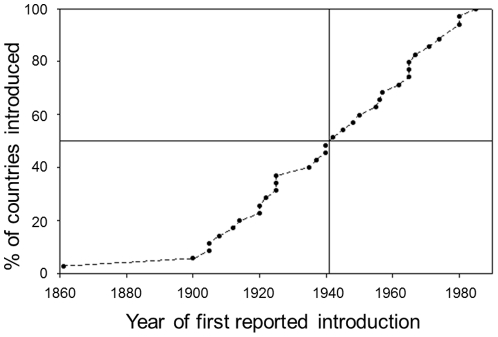
Cumulative percentage of countries subject to guppy introductions over time.Only those countries for which the date of first introduction is known are included. Gridlines indicate date by which 50% of these countries had been subject to their first guppy introduction.